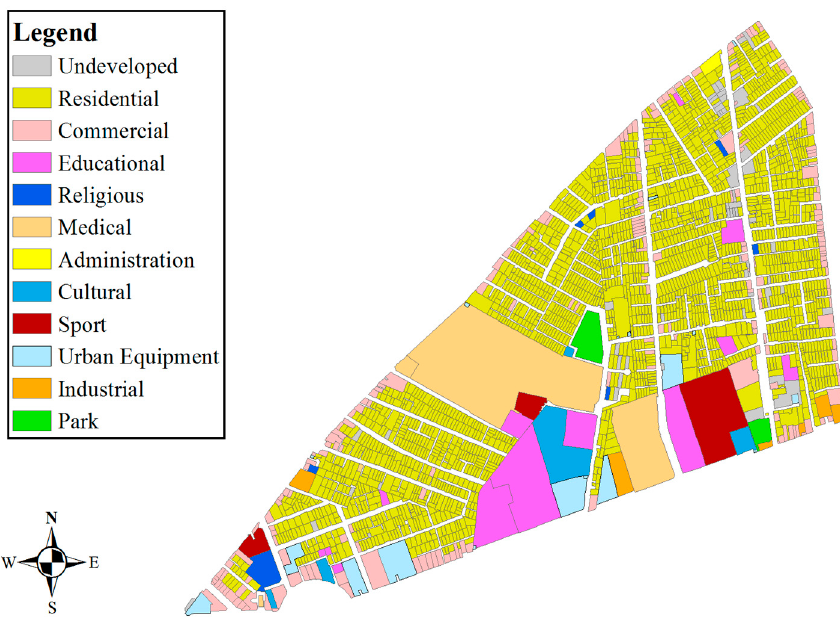
Figure 4. The urban parcels and their land-uses in the study area.